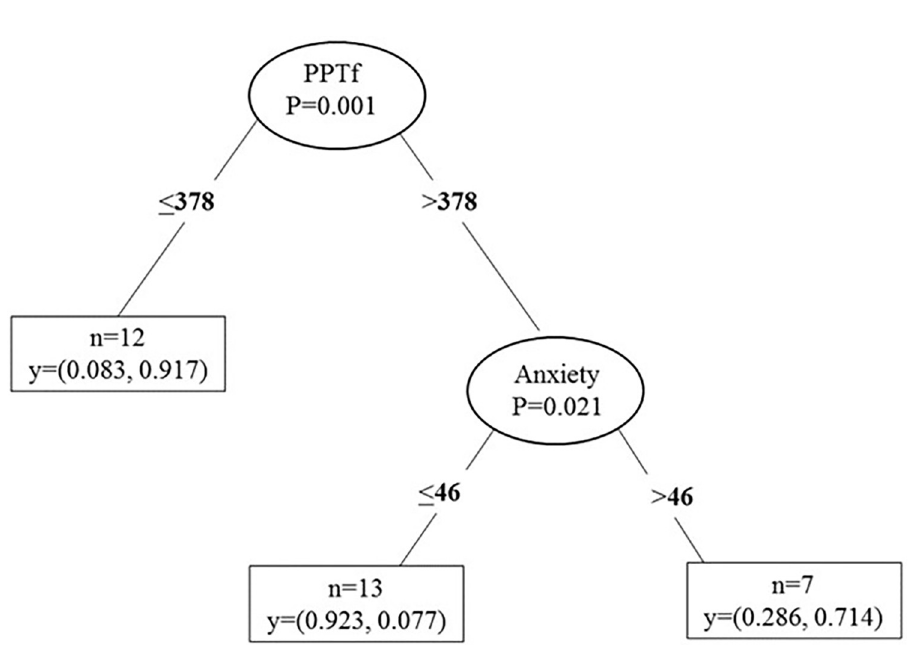
PCS, pain catastrophizing scale; SCQ, situational catastrophizing questionnaire; STAI, Spielberger’s State-Trait Anxiety Inventory; BDI, Beck Depression Questionnaire; FPQ, Fear of Pain Questionnaire; PSS, Perceived Stress Scale. � denotes significant differences between groups p < 0.05.